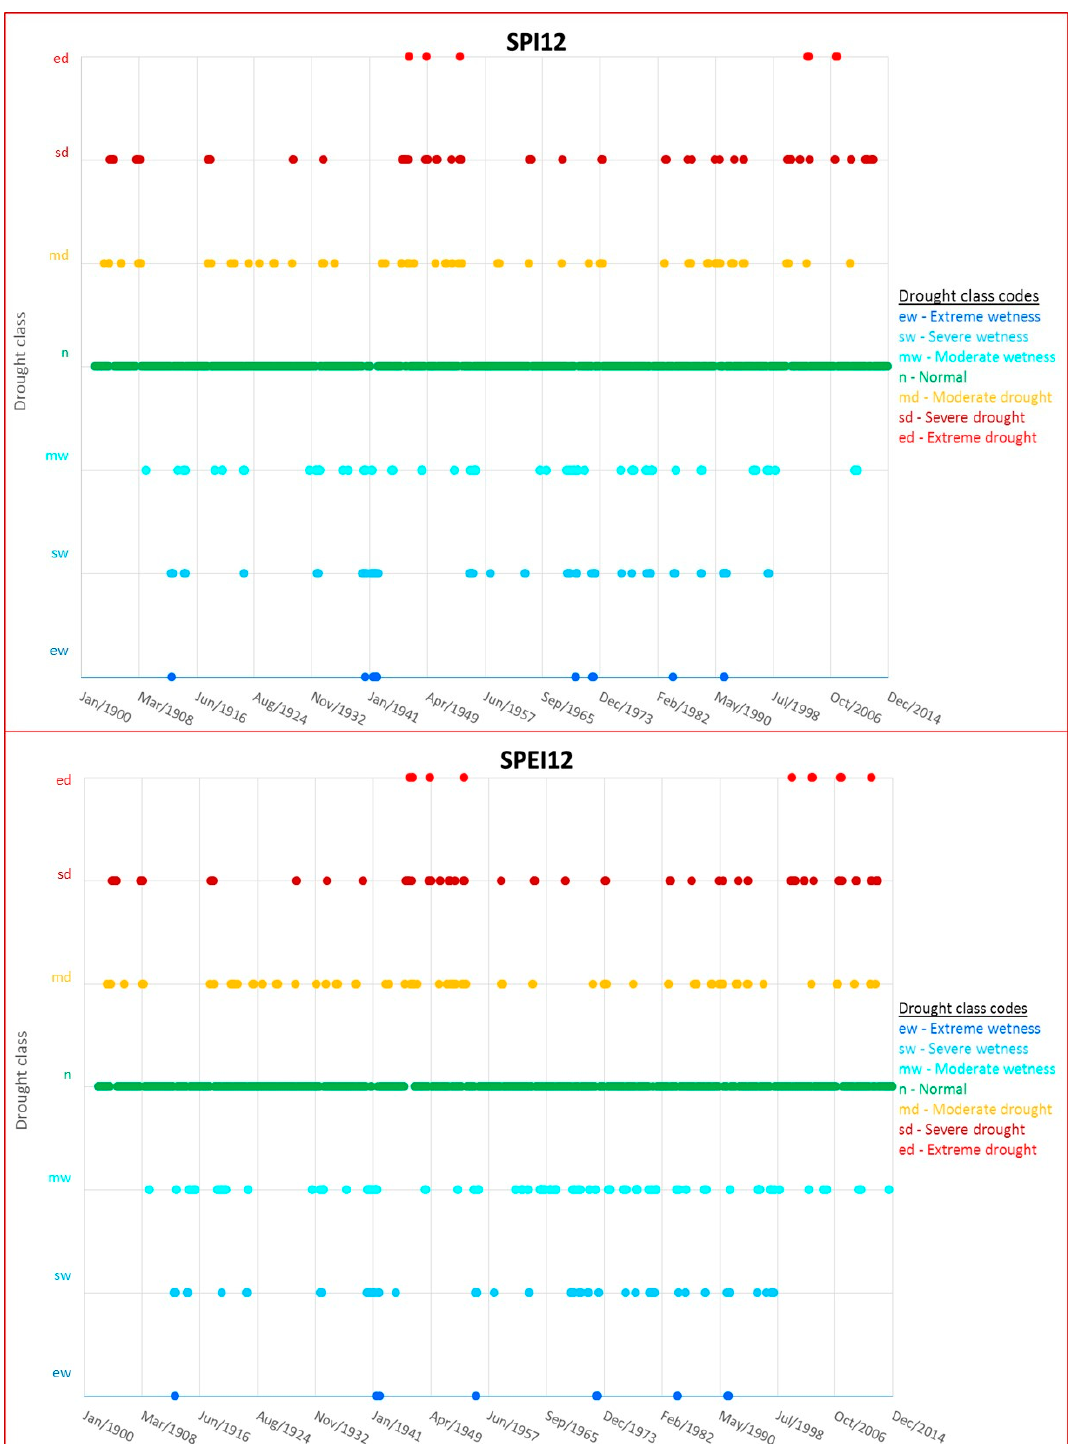
Figure 3. Most frequent classes by month for the SPI12 and SPEI12.